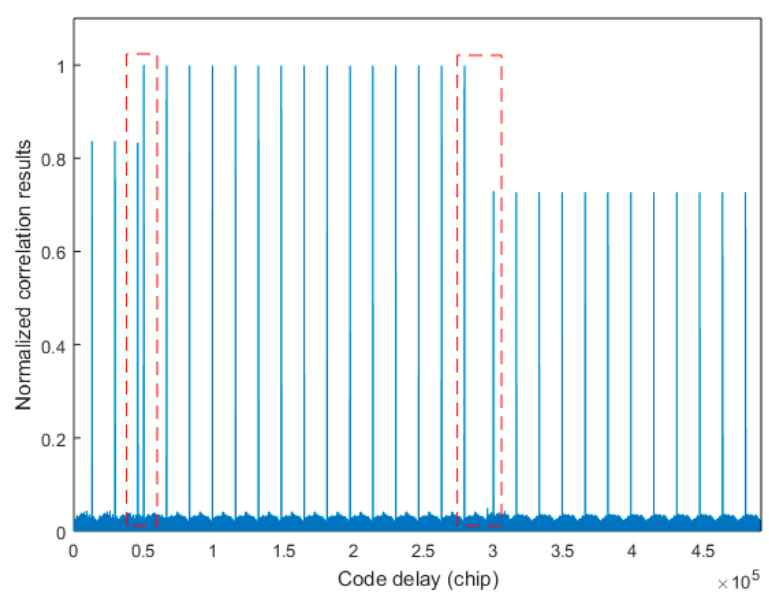
Figure 6. Correlation using the cyclic correlation method.